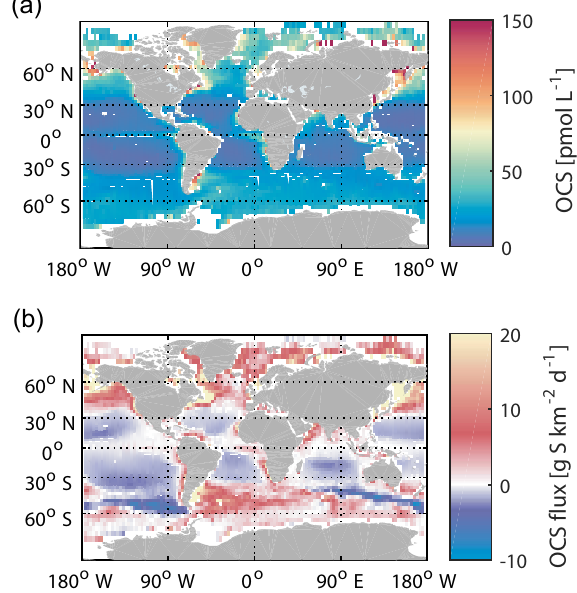
Figure 4. Annual mean of surface ocean concentrations of OCS simulated with the box model (a) and corresponding emissions (b)